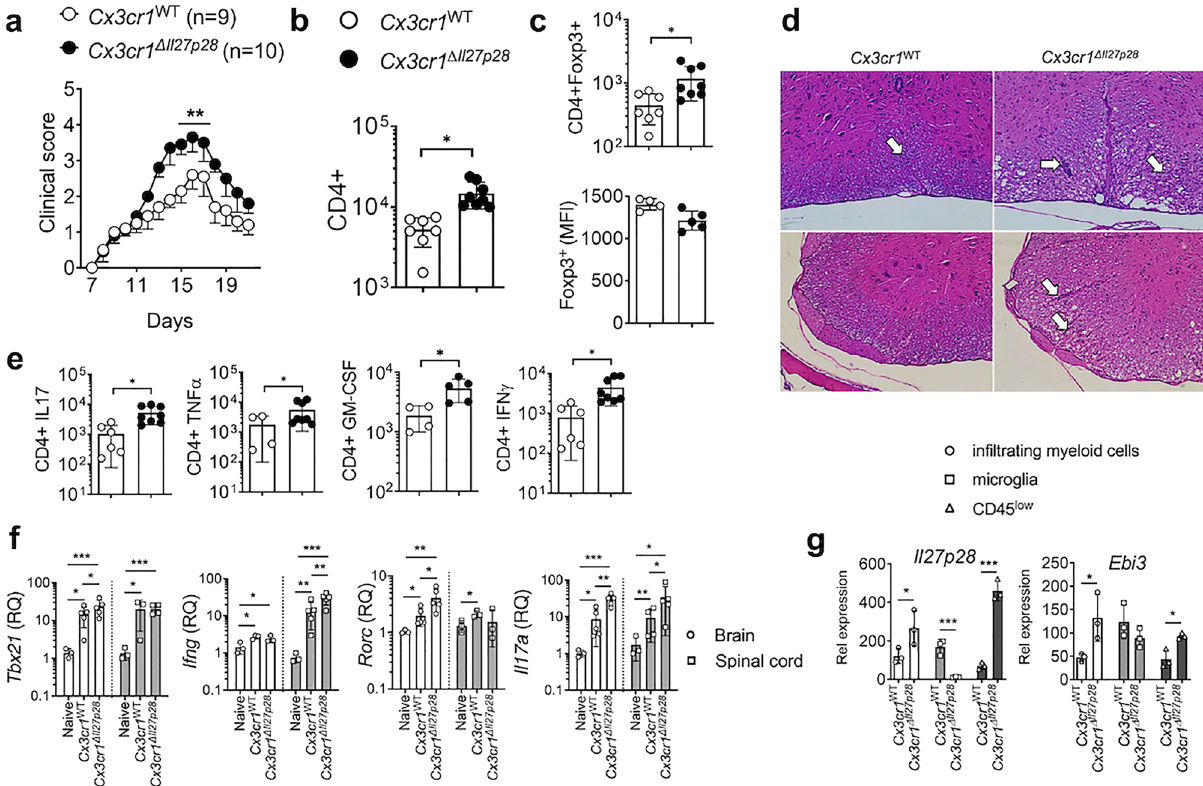
Figure 4. EAE in microglia-specific Il27p28 −/− mice. Cx3cr1 WT (n = 9) and Cx3cr1 Cre Il27p28 fl/f (Cx3cr1 Δ Il27p28 ) (n = 10) were induced for EAE. ( a ) EAE clinical scores. ( b , c ) Total numbers of CNS-infiltrating CD4 + and CD4 + Foxp3 + Treg cells, and the mean fluorescence intensity (MFI) of Foxp3 was determined by flow cytometry at day 17 post immunization. ( d ) At day 18 postimmunization, tissue sections of the spinal cords were stained with H&E. Arrows indicate infiltration of inflammatory cells. × 200 magnification. ( e ) Flow cytometry analysis of GM-CSF, IFNγ, IL-17, and TNFα CD4 + T cells from the CNS of EAE mice (day 17 post immunization). ( f ) qPCR analysis of the indicated mRNAs in the brain and spinal cords from naïve, Cx3cr1 WT , and Cx3cr1 Δ Il27p28 mice 17 days post immunization. Gene expression was normalized by Gapdh and compared to that of naïve mice. n = 3–5 per group. ( g ) qPCR analysis of the indicated mRNAs in freshly sorted CD45 high CD11b high (infiltrating myeloid cells), CD45 int CD11b high (microglia) and CD45 low (including astrocyte and oligodendrocyte) cells from Cx3cr1 WT or Cx3cr1 Δ Il27p28 mice 17 days post immunization. n = 3 per group. *p < 0.05; **p < 0.01; ***p < 0.001; as determined by Mann–Whitney nonparametric